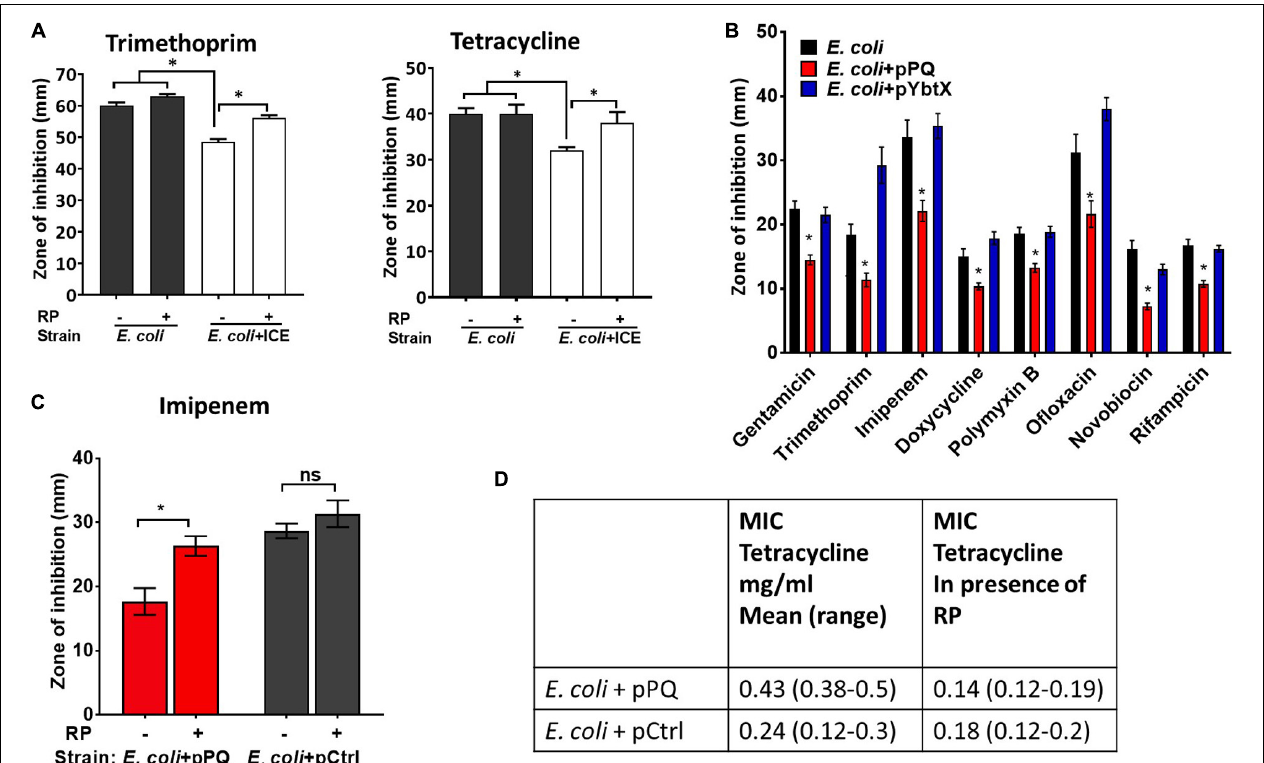
FIGURE 6 | Antimicrobial susceptibility of E. coli was reduced by ICEKp or by YbtPQ alone. (A) Transconjugant E. coli + ICE carrying the ICEKp was significantly less sensitive than E. coli to trimethoprim and tetracycline in a disk diffusion assay (25 and 10 µ g per disk, respectively). Inhibition of efflux using reserpine (50 µ g/disk) significantly increased the susceptibility of the transconjugant to each antimicrobial. Reserpine (RP) had no significant effect on the susceptibility of parental E. coli to either antimicrobial. (B) E. coli carrying plasmid pPQ, encoding YbtPQ, were significantly less susceptible to all antimicrobials tested, whereas control plasmid pYbtX had no significant effect on antimicrobial susceptibility. From left to right, disks contained 10 µ g, 5 µ g, 10 µ g, 30 µ g, 300 units, 5 µ g, 30 µ g, or 5 µ g of antimicrobial. (C) The effect of YbtPQ on susceptibility to imipenem was reduced by reserpine. pCtrl indicates a control plasmid without ybtPQ (vehicle only control). Data are the mean and standard deviation of six replicates. Strains and conditions were compared by Student’s t test. * indicates p < 0.05. (D) The effect of YbtPQ on the minimum inhibitory concentrations (MIC) of E. coli for tetracycline was determined using E-test assay in the presence or absence of reserpine (RP 50 µ g/ml) in triplicate (range tested was 0.016–256 µ